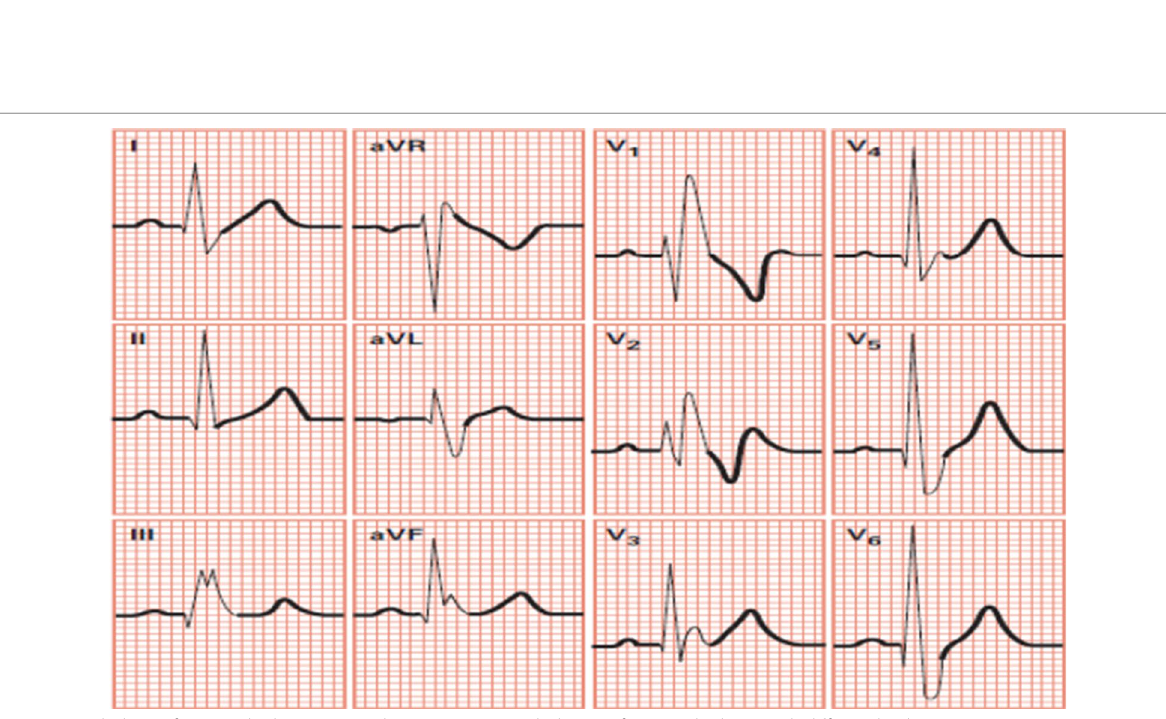
Fig. 3 Morphology of RBBB arrhythmia: Figure shows various morphologies of RBBB arrhythmia with different